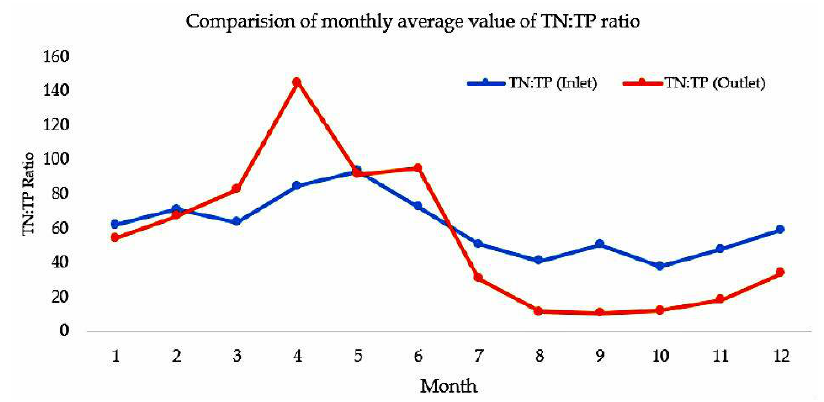
Figure 2. Seasonal patterns of TN:TP (total nitrogen:total phosphorus) ratios at both inlet and the outlet of Lake Vombsjön.